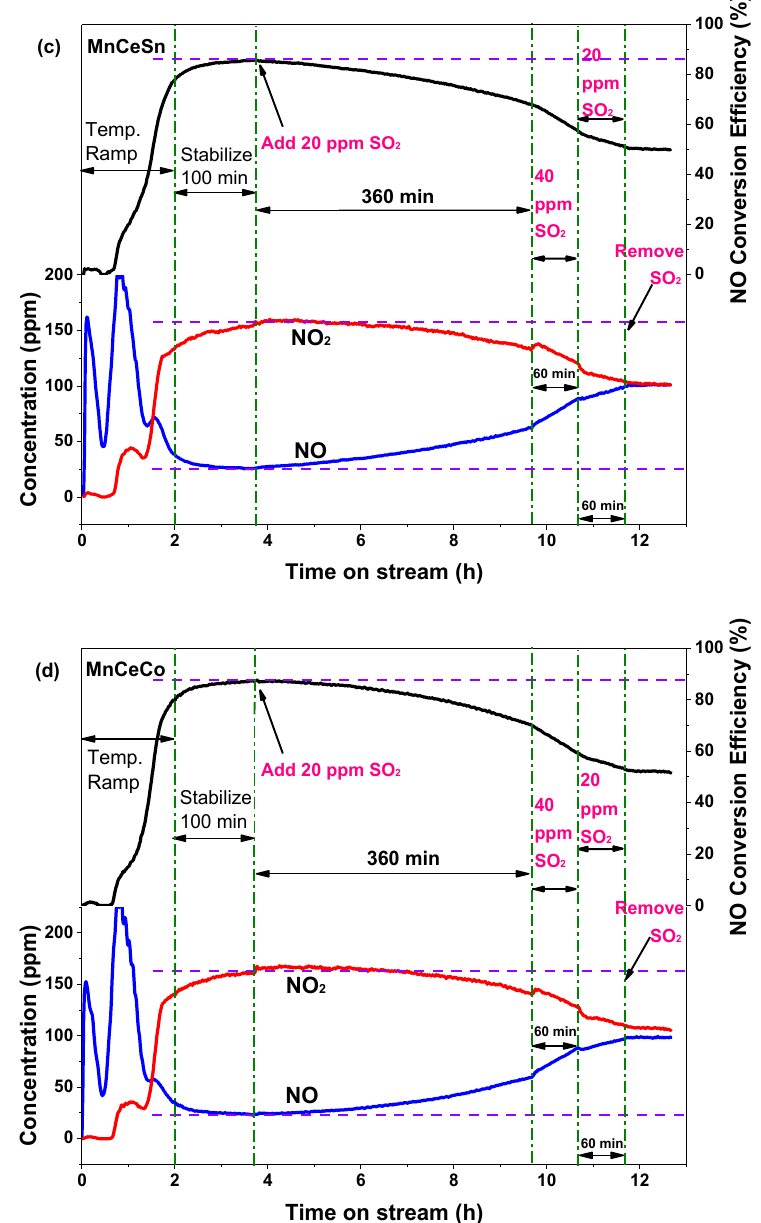
Figure 6. E ff ect of SO 2 on NO conversion e ffi ciency at 250 ◦ C: ( a ) MnCe, ( b ) MnCeFe, ( c ) MnCeSn, and Figure 6. Effect of SO 2 on NO conversion efficiency at 250 °C: ( a ) MnCe, ( b ) MnCeFe, ( c ) MnCeSn, and ( d ) ( d ) MnCeCo.